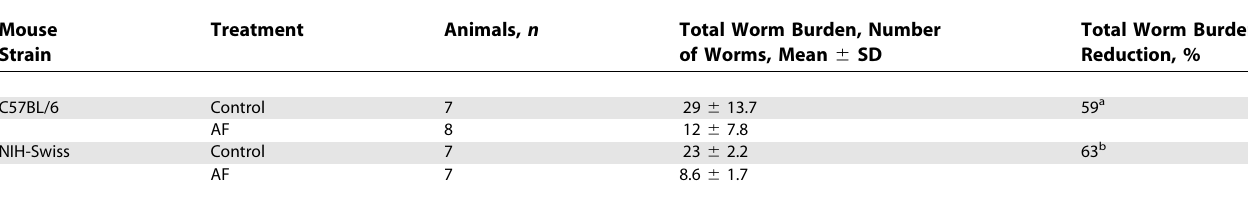
Table 5. Effect of AF Treatment in Mice Experimentally Infected with S. mansoni Mouse Treatment Animals, Strain